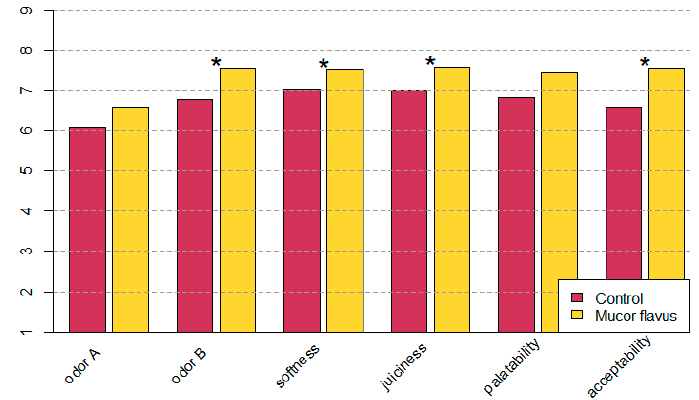
Figure 5. The results of consumer evaluation of the sensory quality of dry-aged beef. Significant differences according to Student’s t -test (at p < 0.05 are marked with *).